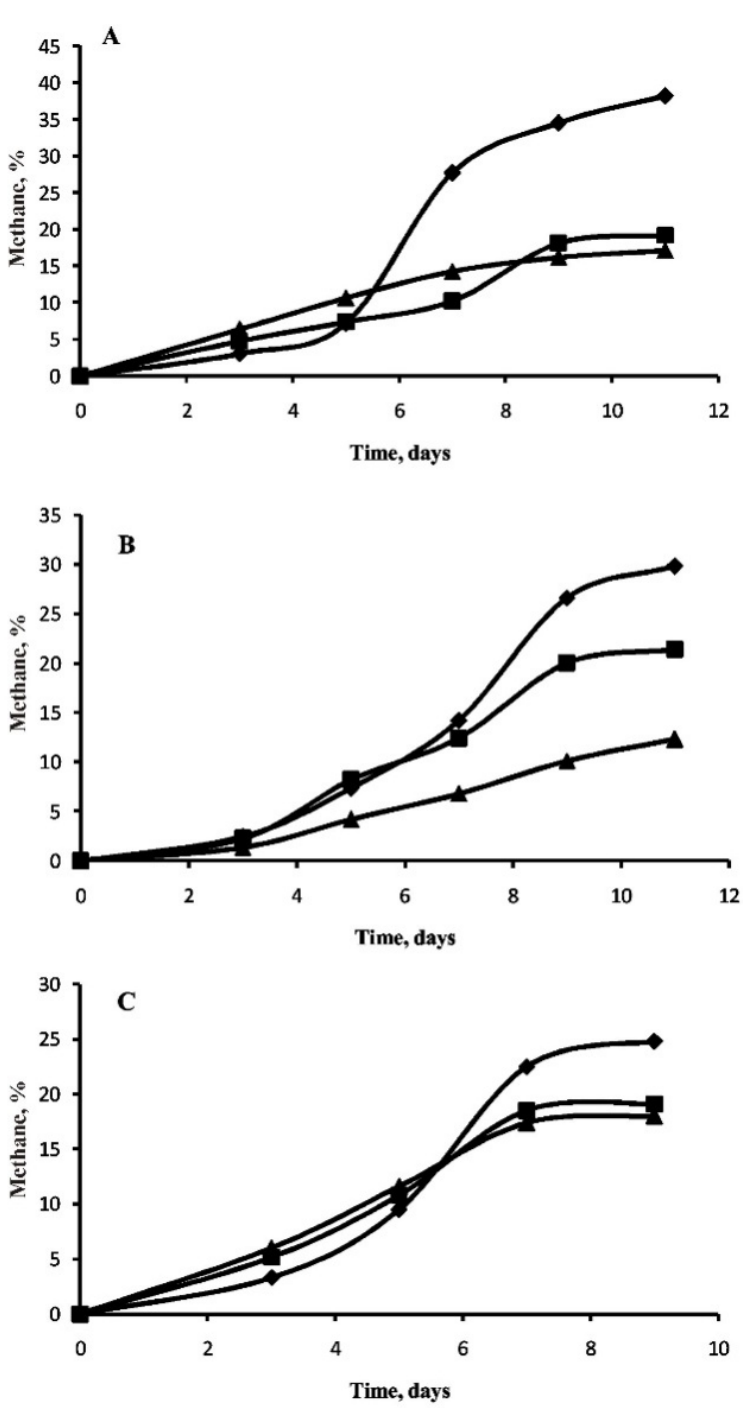
Figure 2. Methane formation by hydrogenotrophic strains M. bryantii M.o.H. T ( A ), M. veterum MK4 T ( B ) and M. arcticum M2 T ( C ) with NaClO 4 (square), Mg(ClO 4 ) 2 (triangle) and without perchlorates